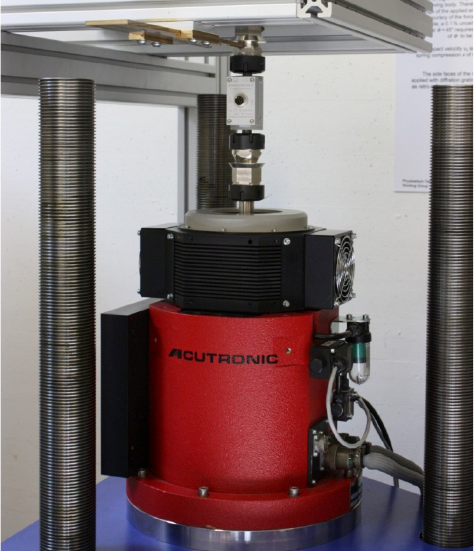
Fig. 13. Dynamic torque measuring device at PTB with the new rotational exciter.